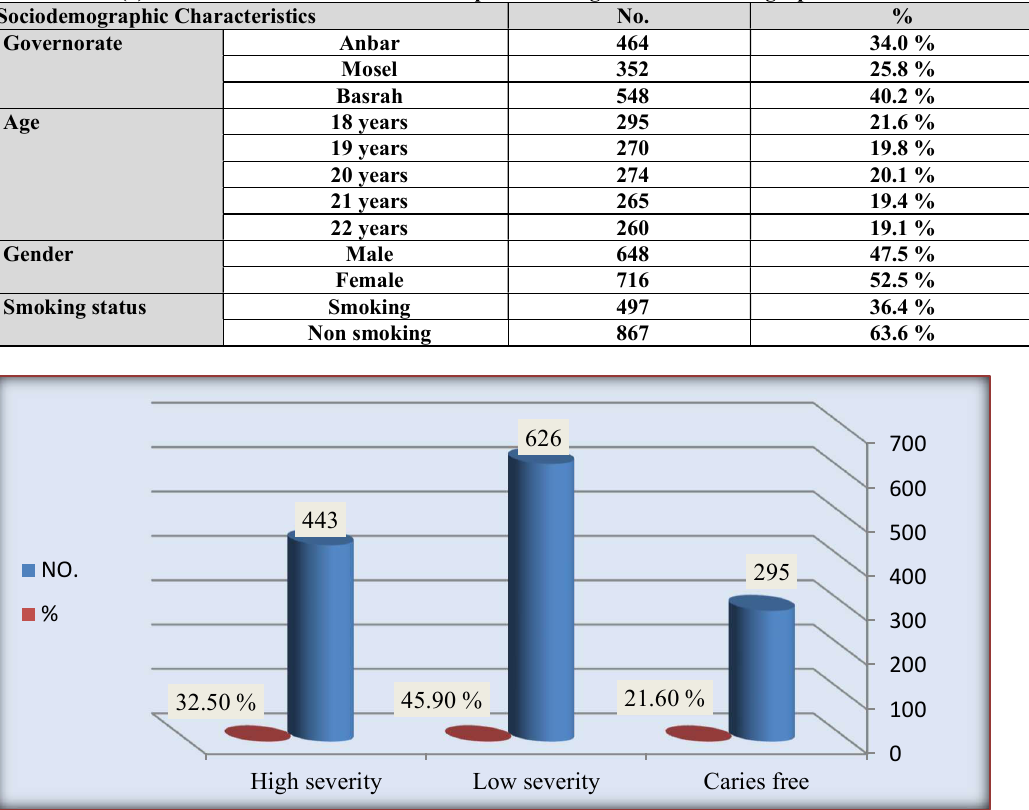
Table (1): The Distribution of the Total Sample according to the Sociodemographic Characteristics. Sociodemographic